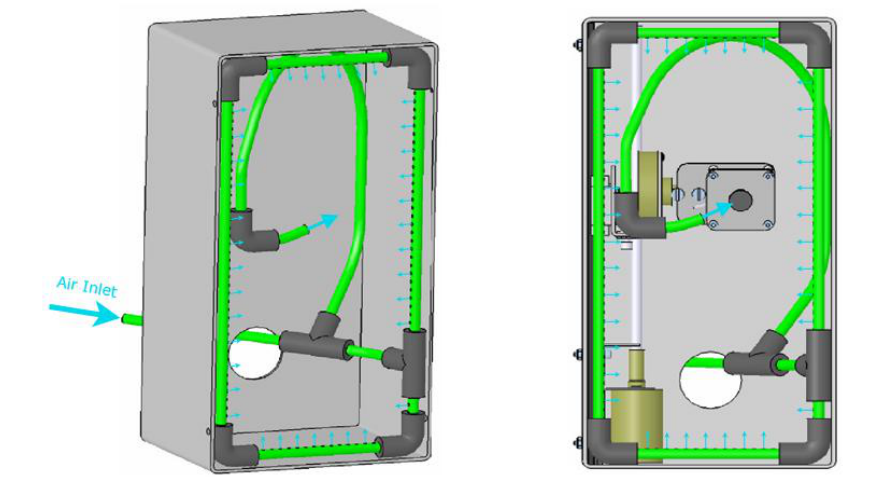
Figure 4. Cooling system.